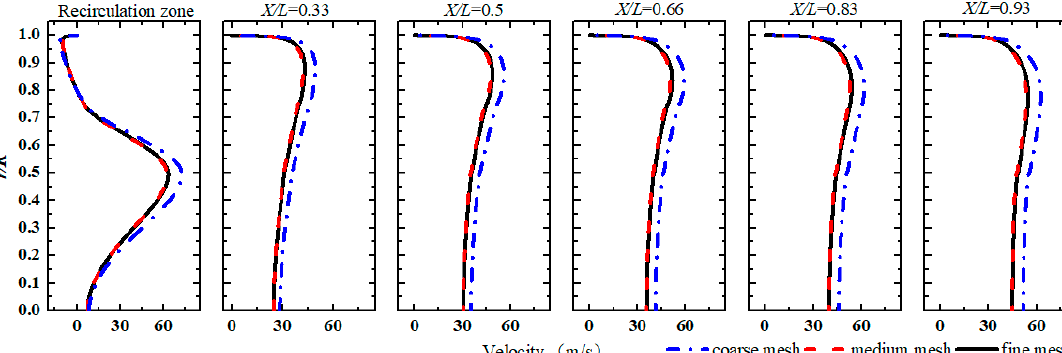
Table 3. Deviation analysis of average regression rate of different mesh number.